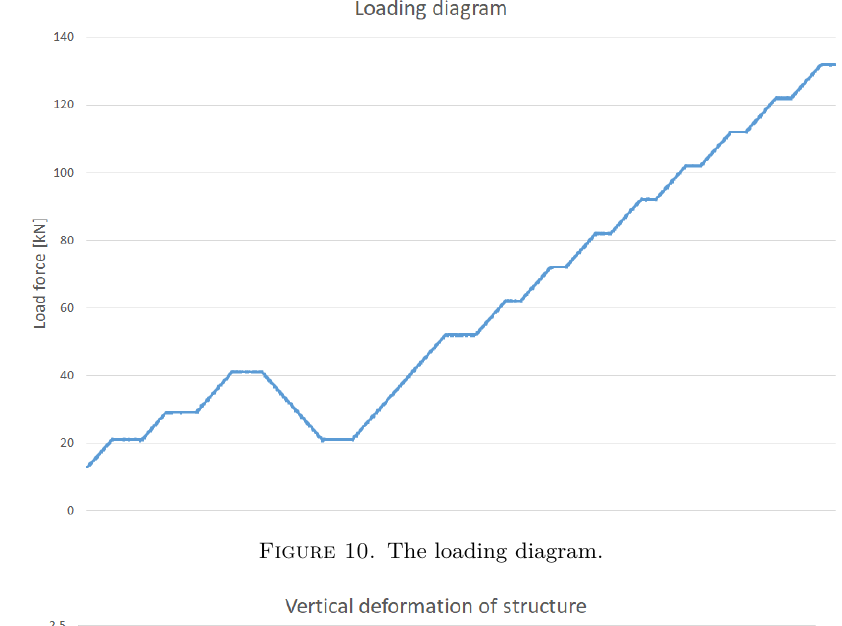
Figure 10. The loading diagram.